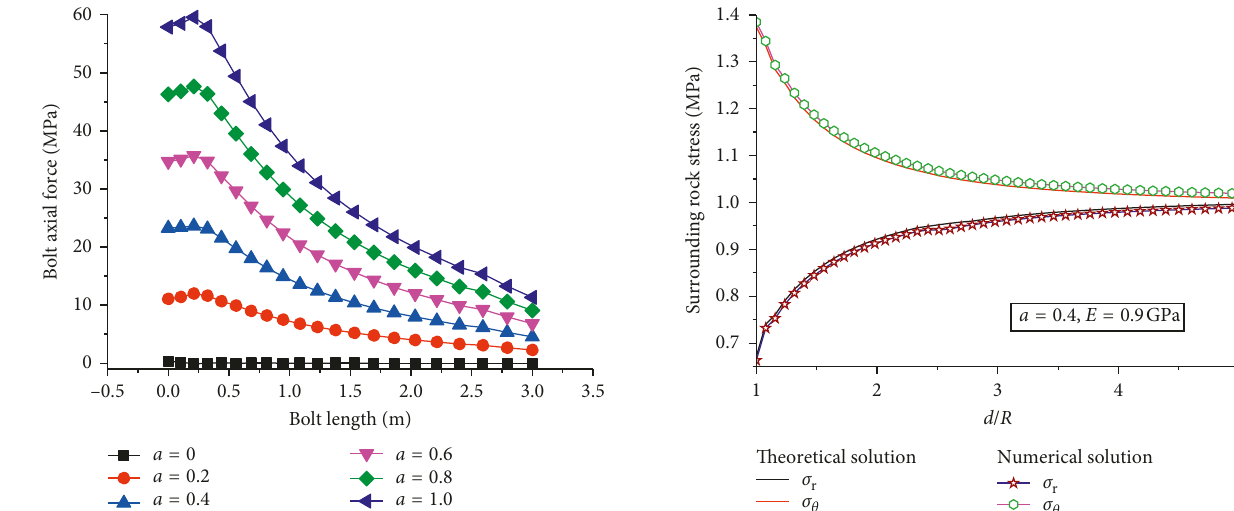
Figure 11: Evolution of bolt axial force with different stress release coefficients.